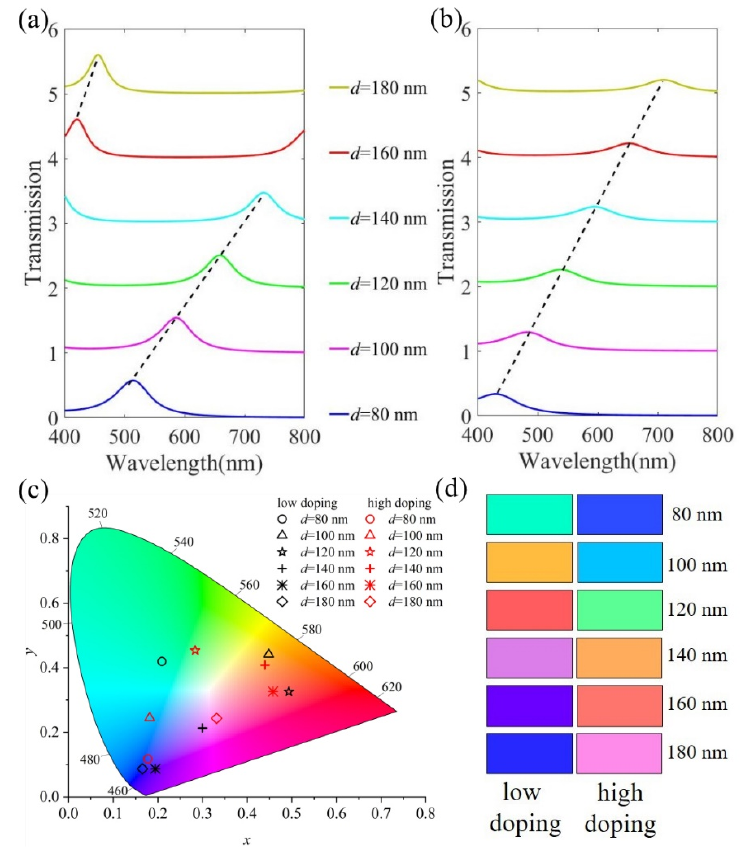
Figure 4. Simulated spectral transmittance curves at normal incidence with different d ( a ) before H 2 plasma treatment and ( b ) after H 2 plasma treatment. ( c ) The corresponding chromaticity diagram for RGB structural colors before and after H 2 plasma treatment. ( d ) The color change corresponds to the ( a , b ) transmission curve.